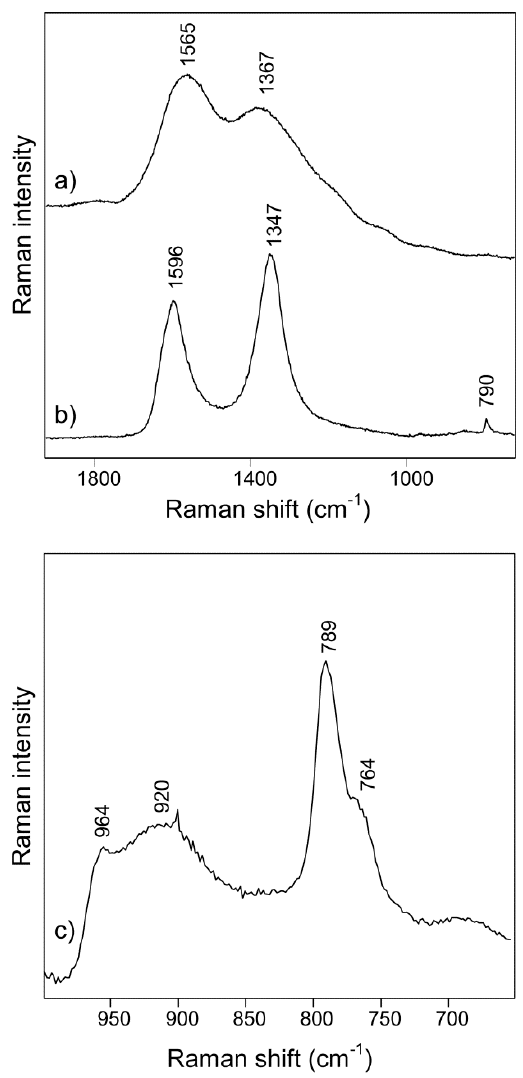
Figure 5. Raman spectra of ( a ) hydrochar of glucose, ( b ) the core-shell C-SiC composite and ( c ) the hollow and spherical SiC particles.